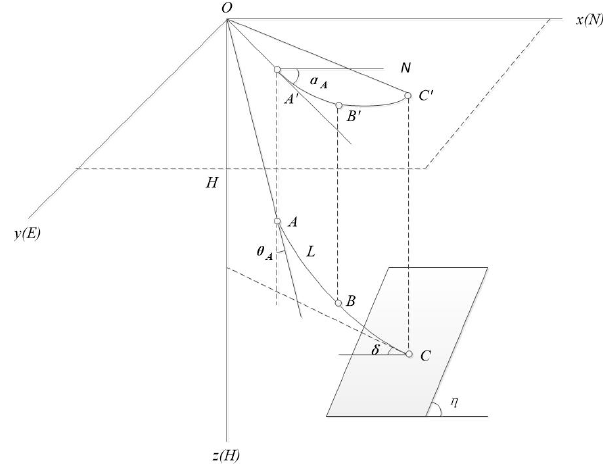
Figure 1. Coordinate system of a borehole